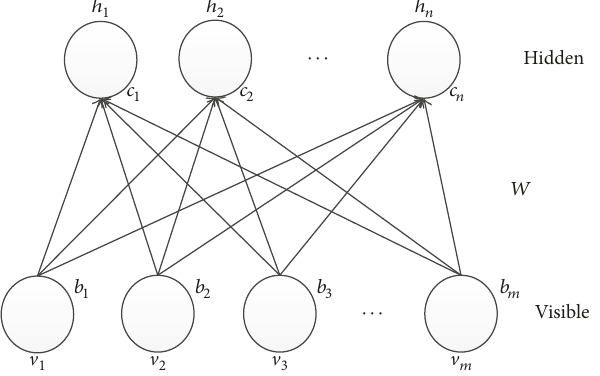
Figure 2: Architecture of restricted Boltzmann